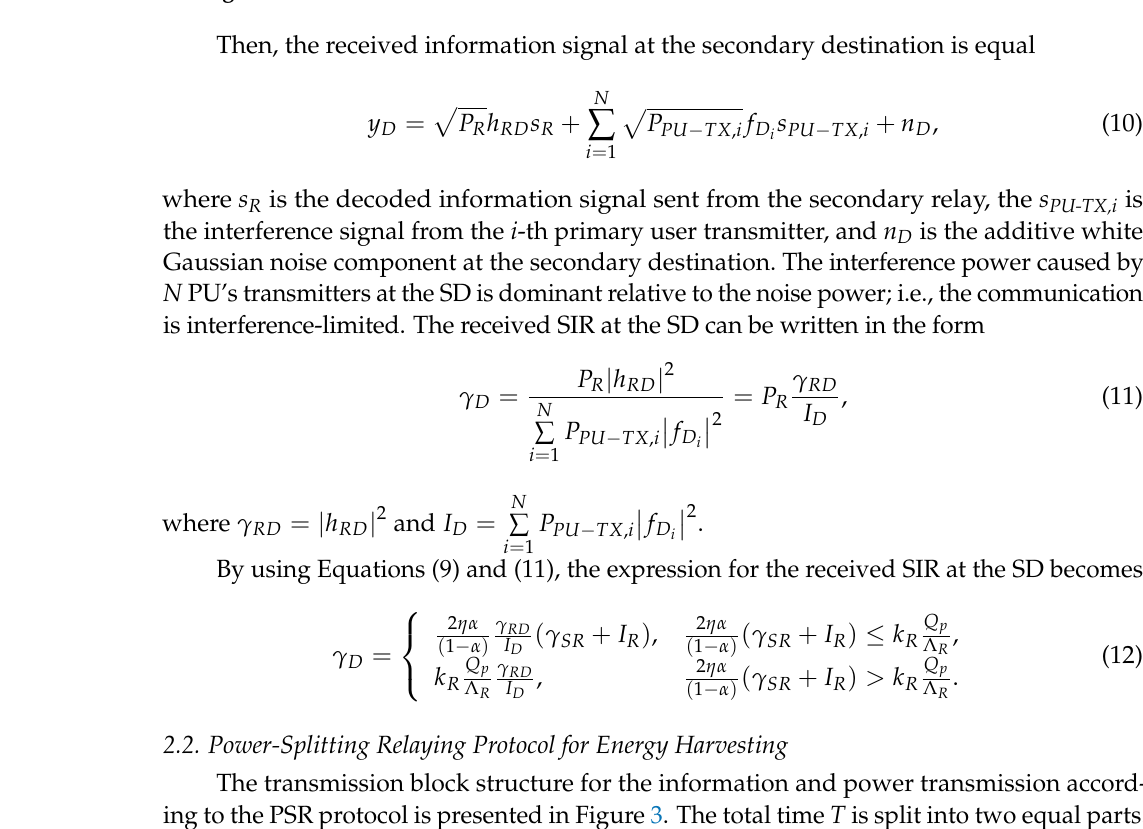
Figure 2. Transmission block structure in the TSR scheme.